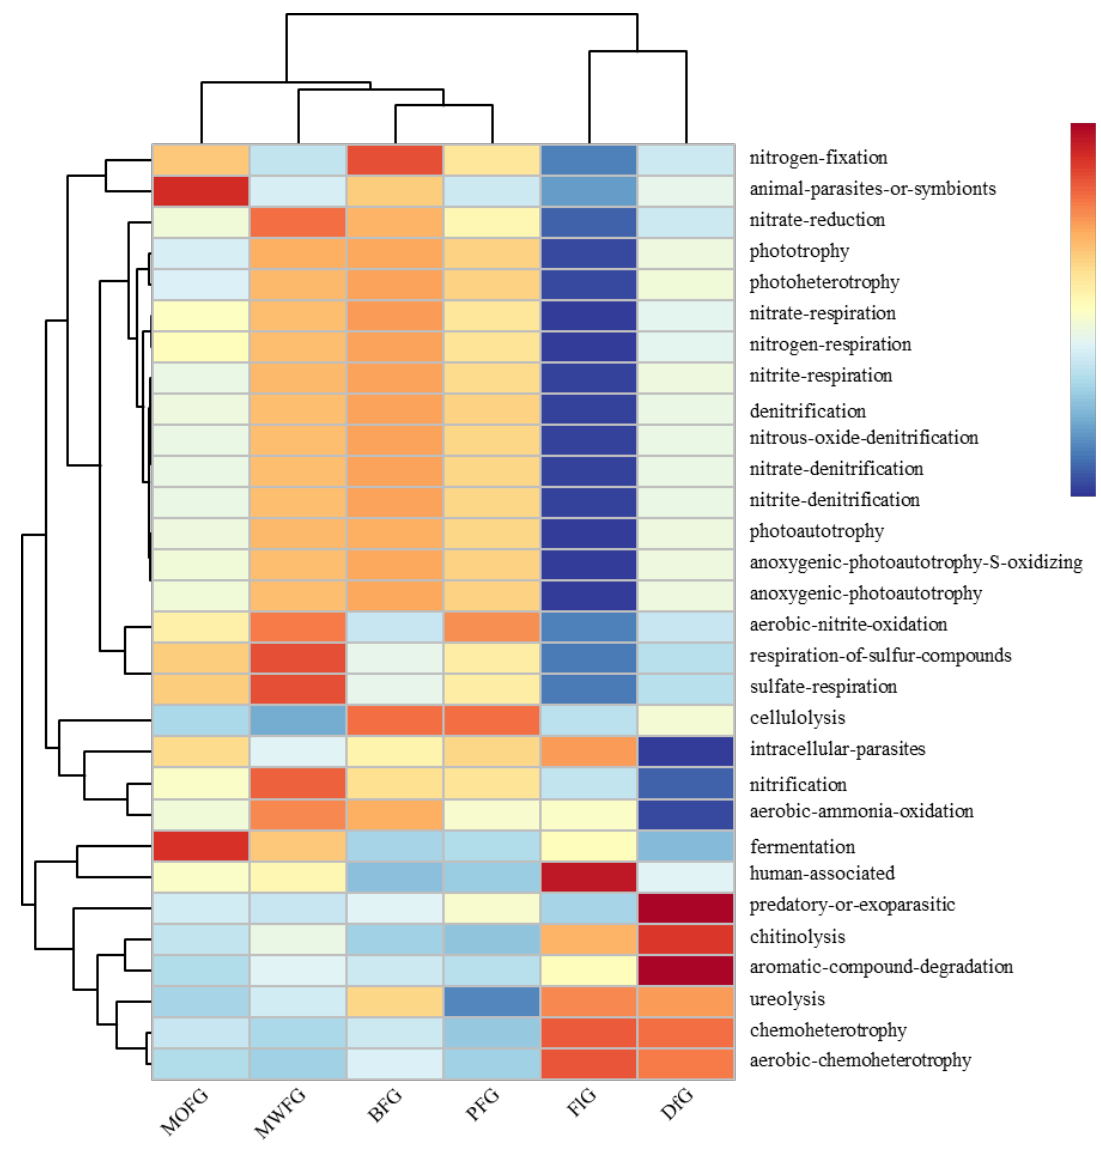
Figure 4. Bacterial function cluster heat map based on FAPROTAX prediction. MOFG, Mongolian oak forest ginseng; BFG, birch forest ginseng; MWFG, miscellaneous wood forest ginseng; PFG, poplar forest ginseng. FlG, farmland ginseng; DfG, deforestation ginseng. The gradient color from blue to red is used to reflect the change in abundance from low to high. The closer the color to blue, the lower the abundance, and the closer to red, the higher the abundance. The heat map is transformed by the Z value to normalize the expression abundance of the same bacteria.